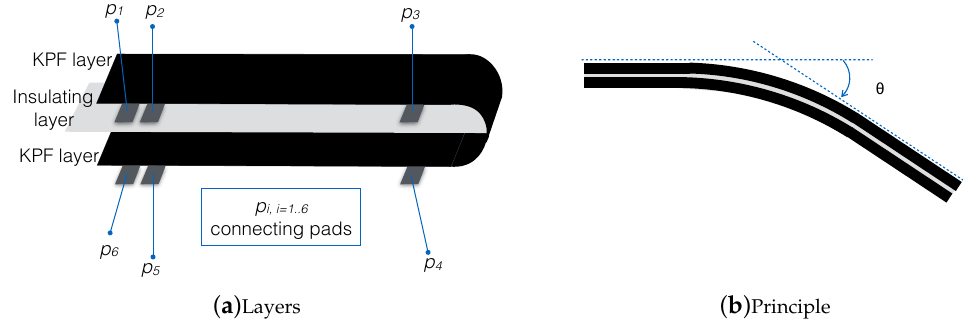
Figure 1. Textile goniometer made of two knitted piezoresistive fabric (KPF) layers. ( a ) The two conductive KPF layers (in black) are coupled through the electrically insulating stratum (in light gray). The device has six connecting pads for power supply and signal acquisition ( p i , i = 1,...,6, in dark grey); ( b ) The difference of electrical resistance ( ∆ R ) between the two sensing layers is proportional to the flexion angle ( θ ), defined as the angle between the planes tangent to the sensor